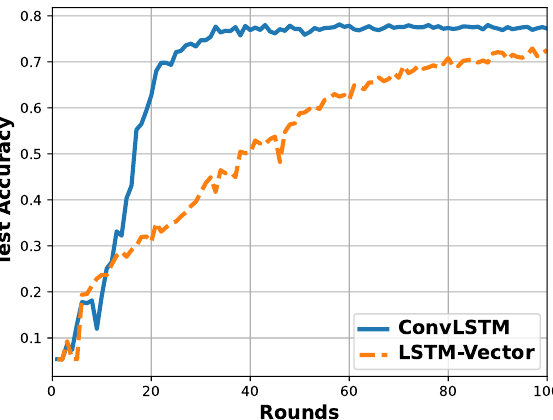
Figure 6. Comparison of test accuracy per round between LSTM-Vector and ConvLSTM.